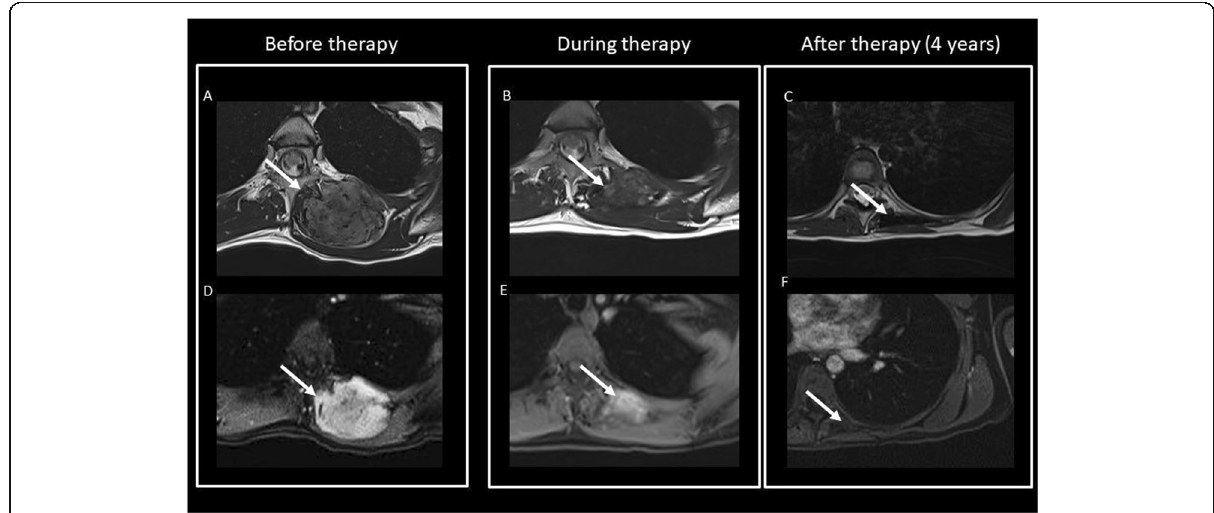
Fig. 18 Chest posterior wall DT (T2wi ( a ) and after contrast T1wi ( d )). A 23-year-old female patient underwent chemotherapy. MRI showed progressive decrease of T2wi signal intensity and contrast enhancement on T1wi of the lesion (white arrow): during therapy, the lesion decreased in dimension and in T2 hyperintensity ( b ) but maintained moderate contrast enhancement on T1wi ( e ). After 4 years, the lesion significantly reduced its dimension, become hypointense on T2wi ( c ), and did not show significant contrast enhancement ( f